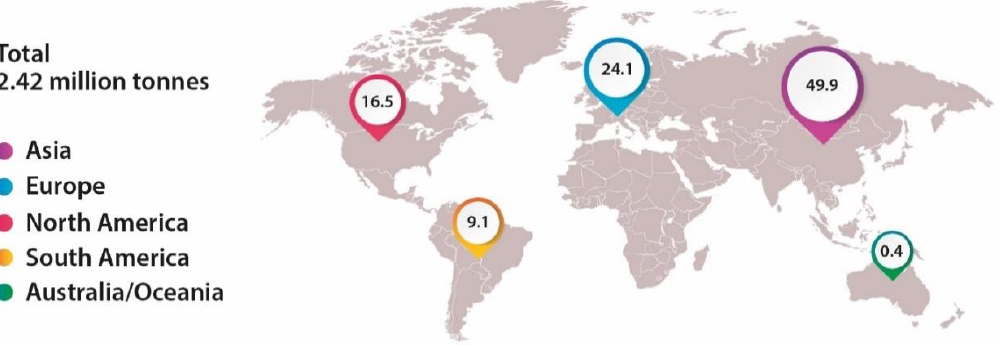
Figure 19. Global production capacities of bioplastics in 2021 (world map). Adapted from “Global production capacities of bioplastics in 2021 (world map)” , https://www.european-bioplastics.org/wp-content/uploads/2021/11/Global_Prod_Capacity2021_map.jpg (accessed 29/12/2022) [76].